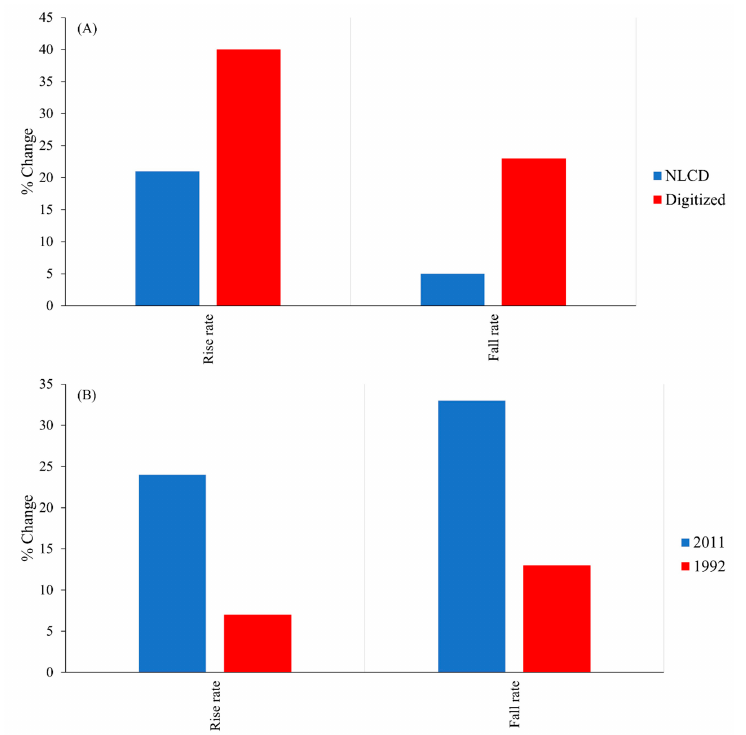
Figure 8. Changes in the rate and frequency of streamflow. Percent differences in the rise and fall rates due to the source of LULC data ( A ) and due to the temporal condition of LULC distribution in the watershed using 1992 and 2011 LULC data ( B ). Monthly low flows : The percent changes in the magnitude of monthly low flows originating from different LULC sources and years are shown in Figure 9. In analyzing the differences in low flows stemming from different LULC sources, results indicate that the NLCD datasets produced smaller changes (except for May and August) (Figure 9A). When differences in simulated low flows under the 1992 LULC data were compared with those produced by 2011, results consistently showed smaller percent differences with the 1992 LULC data, except during May (Figure 9B), indicating a growth in uncertainty from 1992 to 2011.